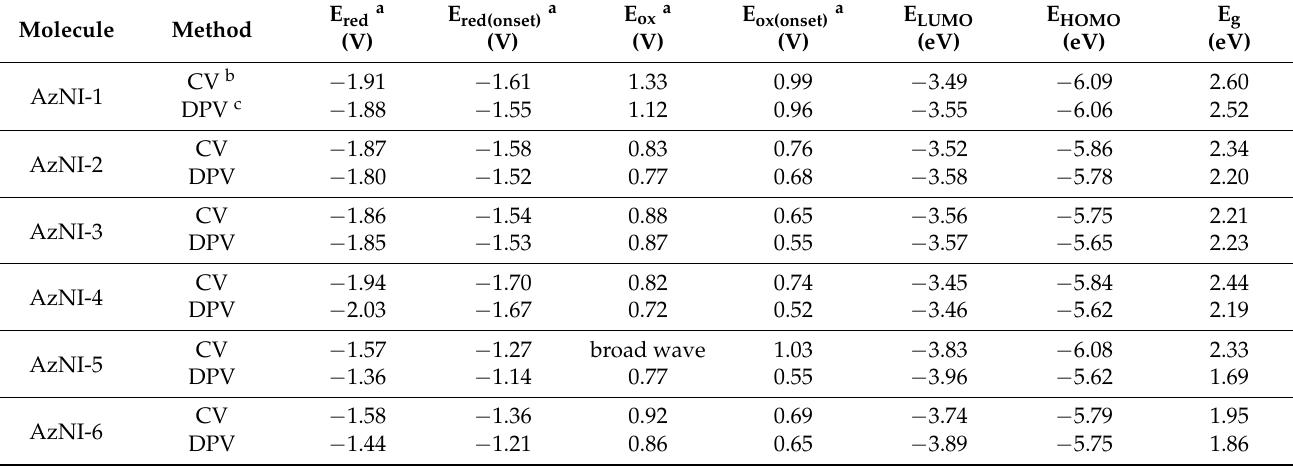
E HOMO = –5,1–E ox(onset) · |e|, E LUMO = –5,1–E red(onset) · |e|, E g = E ox(onset) –E red(onset) . Measurements in CH 2 Cl 2 with c sample = 10 − 3 mol/dm 3 and c electrolyte = 0.1 mol/dm 3 (Bu 4 NPF 6 ), Pt as the working electrode. a Potentials were taken from the first oxidation/reduction processes. b V = 0.10 V/s. c V = 0.05